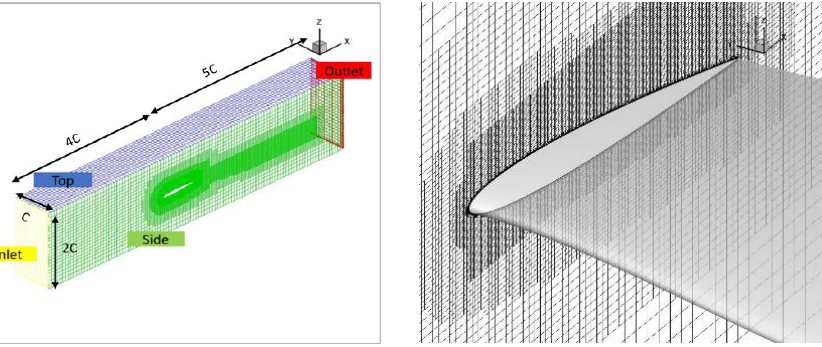
Figure 1. Domain of cavitation tunnel ( left ) and geometry of the Delft Twist11 hydrofoil ( right ). The commercial CFD (Computational Fluid Dynamics) software Star-CCM+13.06 was used. The governing equation and turbulence model were RANS (SST k- ω ), DES (SST k- ω ), and LES models. The Eulerian Multiphase model was used to simulate the formation of cavitation due to the pressure drop in the fluid. Additionally, the cavitation model was the Schnerr–Sauer model. To measure URN, a direct method was used to directly predict the measured pressure at a